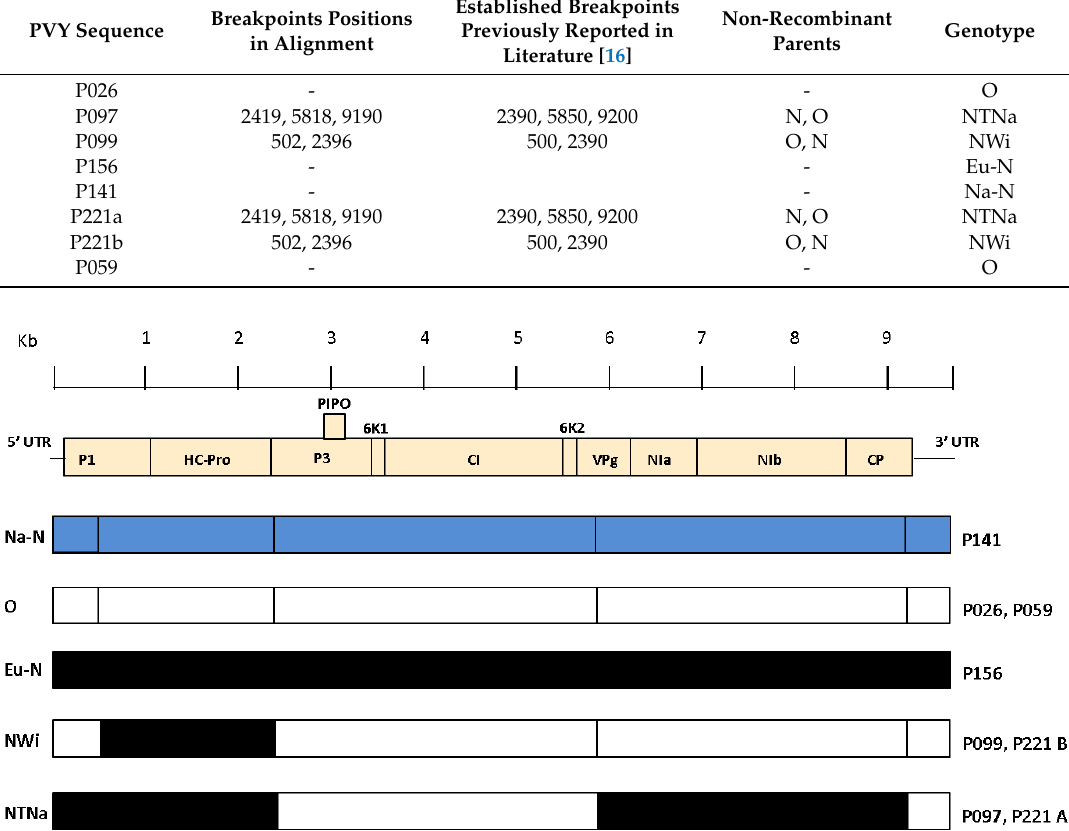
Table 5. Recombination events identified in the sequenced PVY isolates.